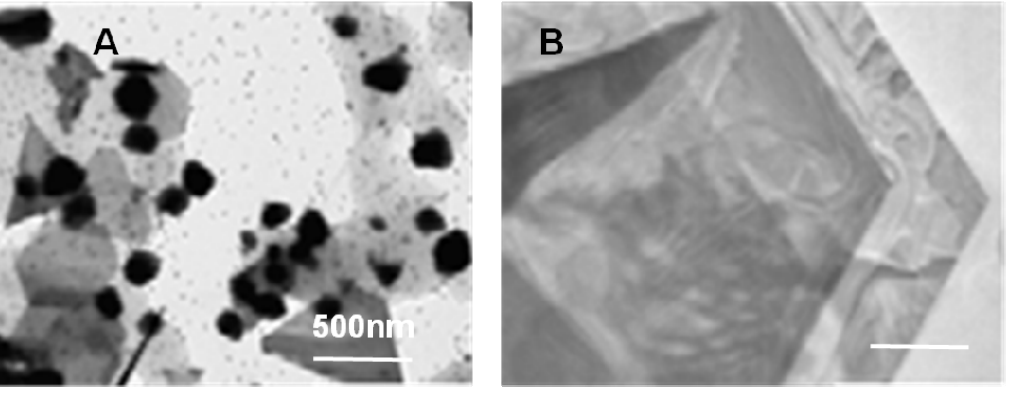
Figure 4. Gold nanoparticle formation in the presence of Midas-2 peptide, and gold platelet formed in the presence of Midas-11 peptides. Reprinted from [56] with permission from Elsevier. Copyright